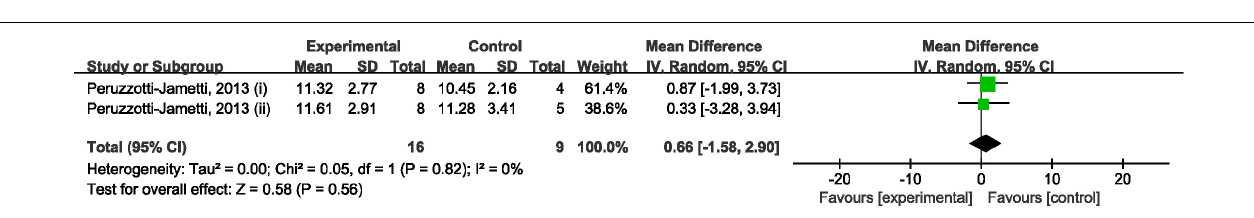
FIGURE 3 | Forest plot analysis of the efficacy of cathodal tDCS on infarct size compared to controls divided on: (A) duration of ischemia; (B) anesthesia used during tDCS procedure.